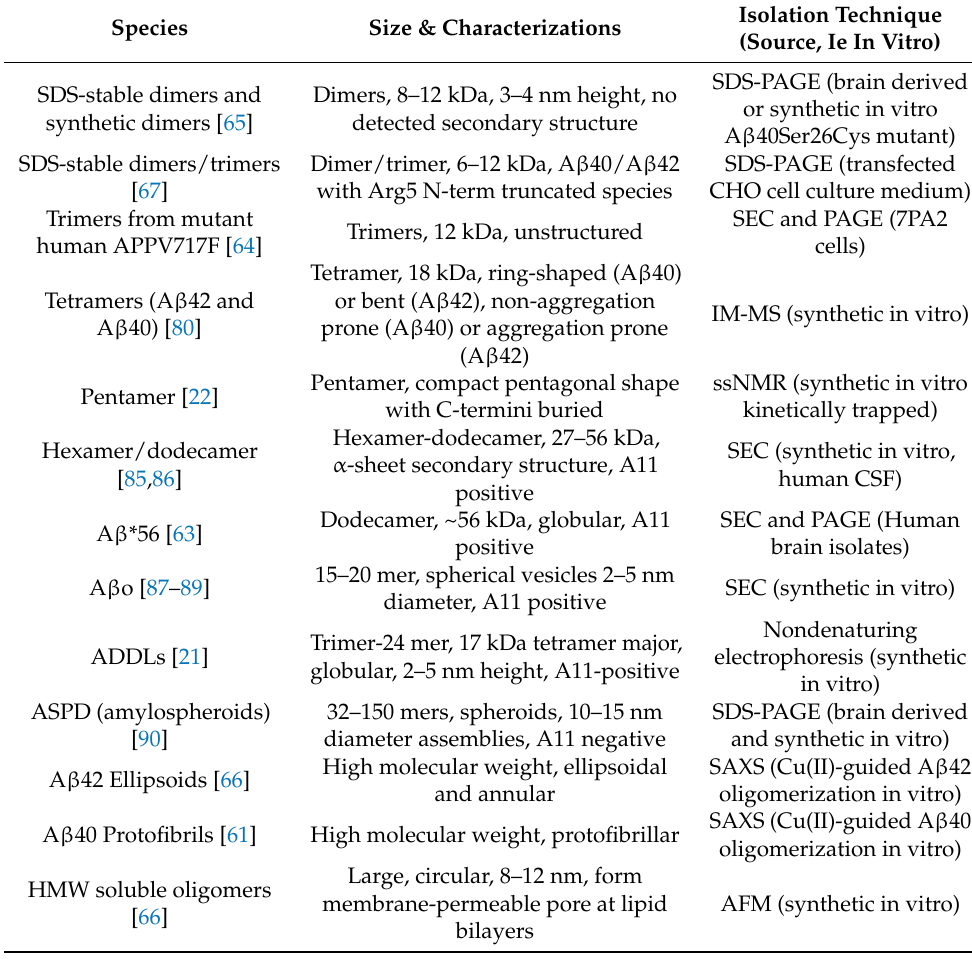
Table 1. A β oligomers observed in different studies and by different